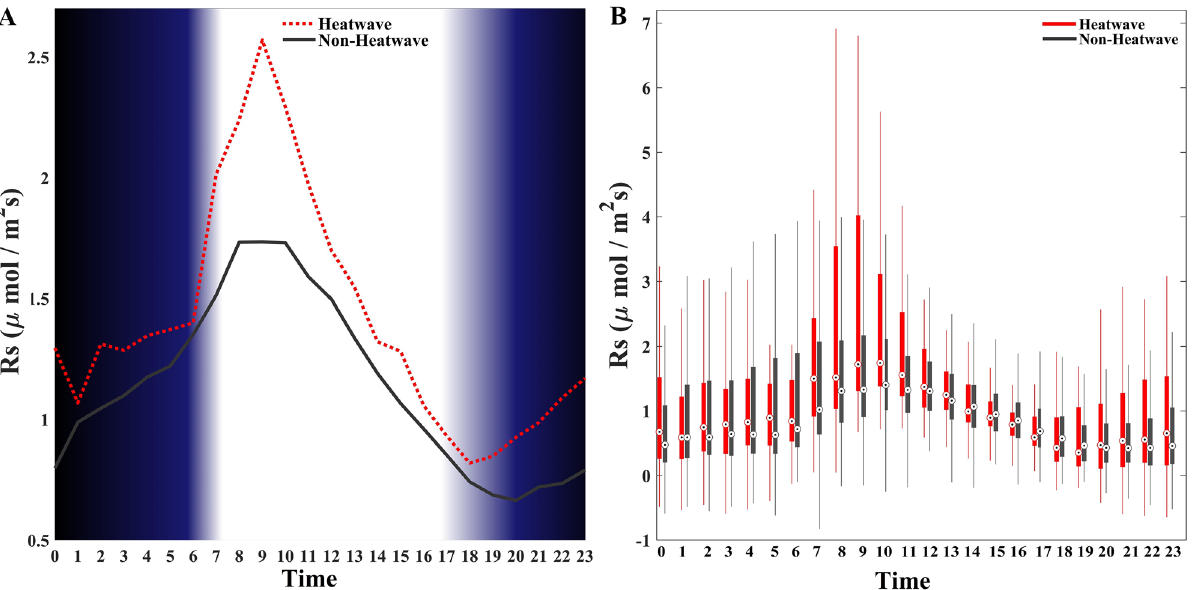
Figure 3. Mean diel Rs cycle and variability during heatwave and non-heatwave conditions at the San Joaquin Marsh Reservoir (SJMR) using the long-term hourly mean across all months. Local time (UTC-8 h) is shown. ( A ) Gradients in the shading denote dawn (5:45–7:15) and dusk (17:00–20:00). ( B ) Boxplots of Rs under heatwave (red) and non-heatwave (black) conditions. Each pair of boxplots represent the range of observed values for one hour of the day (in local time) under the various conditions, where the bottom (top) edge of the box indicates the 25th (75th) percentile and the circles demarcate the